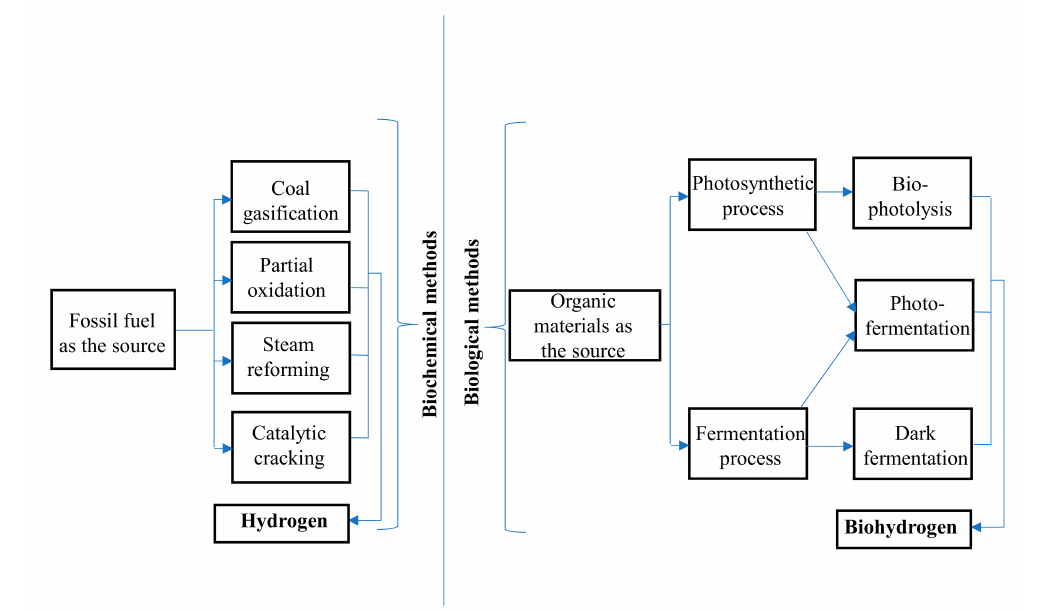
Figure 2. Schematic diagram of the hydrogen production